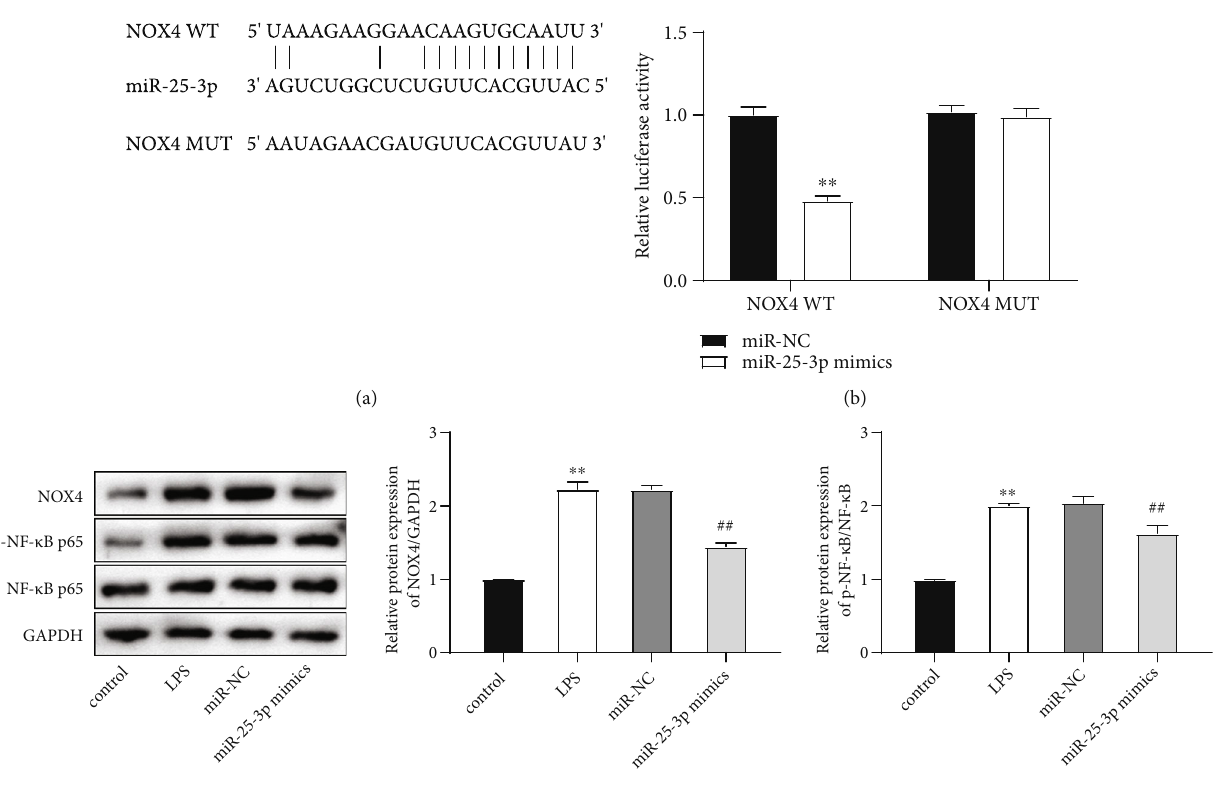
Figure 8: MiR-25-3p blocks the NOX4/NF- κ B signalling pathway in LPS-treated H9C2 cells. (a) The WT binding site of NOX4 with miR- 25-3p was predicted by miRDB and relevant mutant (MUT) sequence. (b) The target relationship between NOX4 and miR-25-3p was validated by luciferase reporter assay. (c) The protein levels of NOX4 and p-NF- κ B p65/NF- κ B p65 were measured by western blot. ** P < 0 : 01 versus control. ## P < 0 : 01 versus LPS